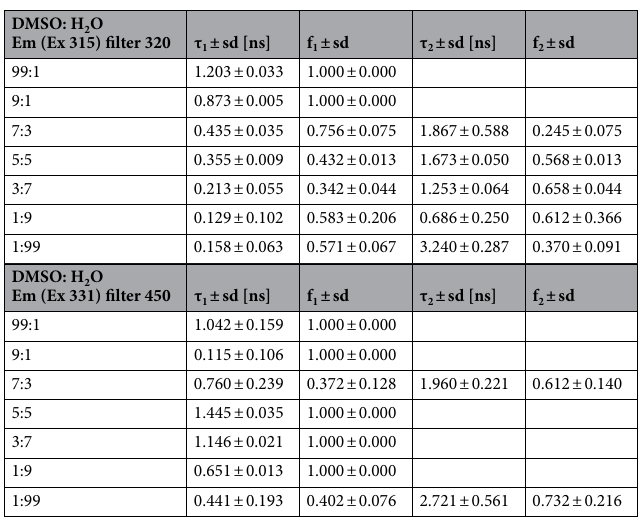
Table 2. Fluorescence lifetimes τ [ns], fractional intensities f and standard deviation measured for NTBD at various DMSO: H 2 O volume